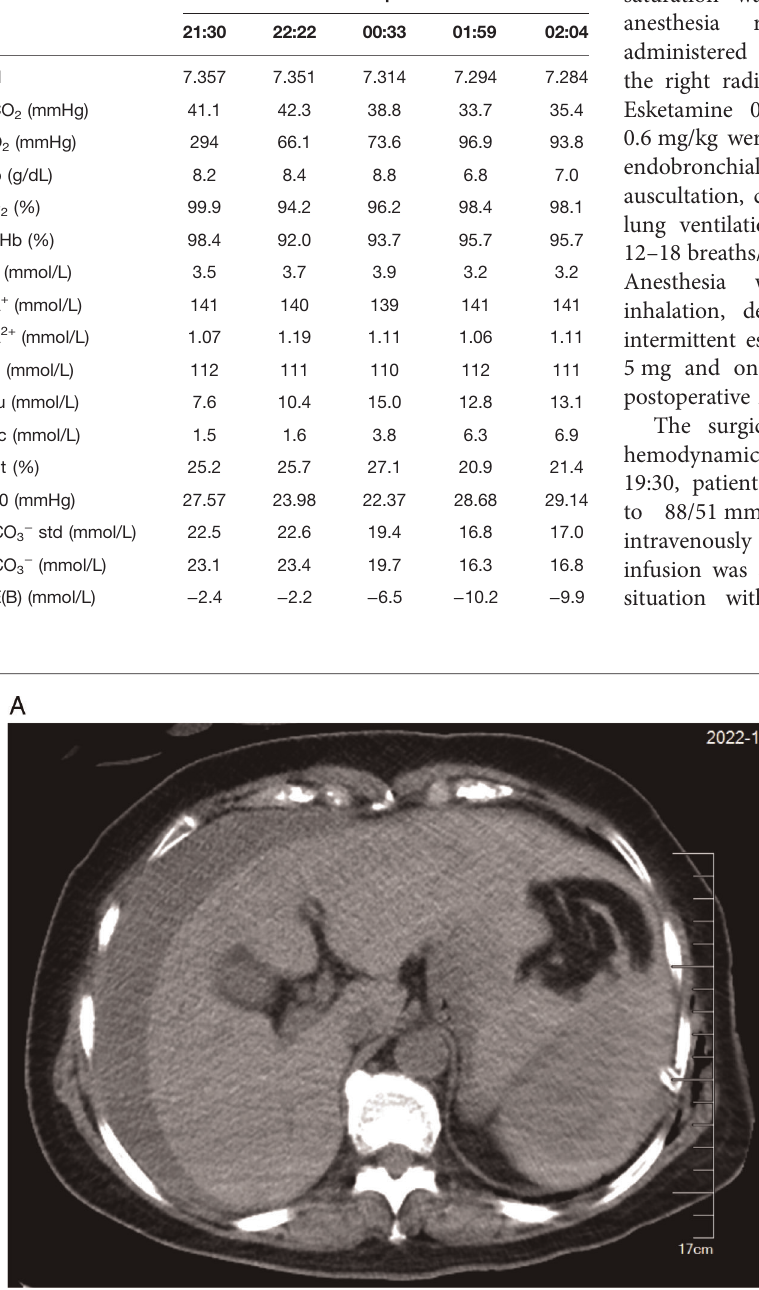
FIGURE 1 | Images of abdominal computed tomography and ruptured spleen. ( A ) Abdominal computed tomography showing splenic hematoma and large amount of free intraperitoneal fl uid. ( B ) Two lacerations of the ruptured